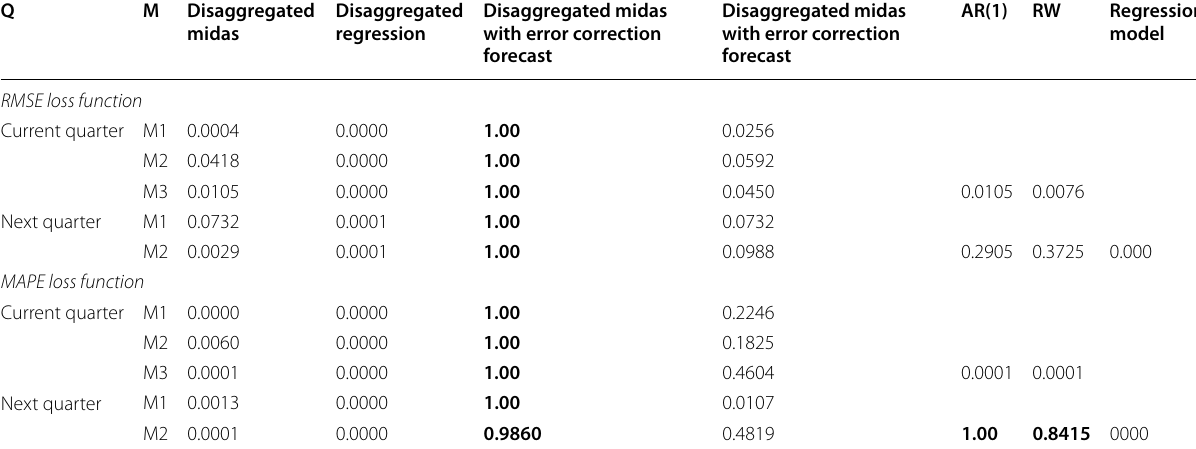
Table 17 p values from model the confidence test